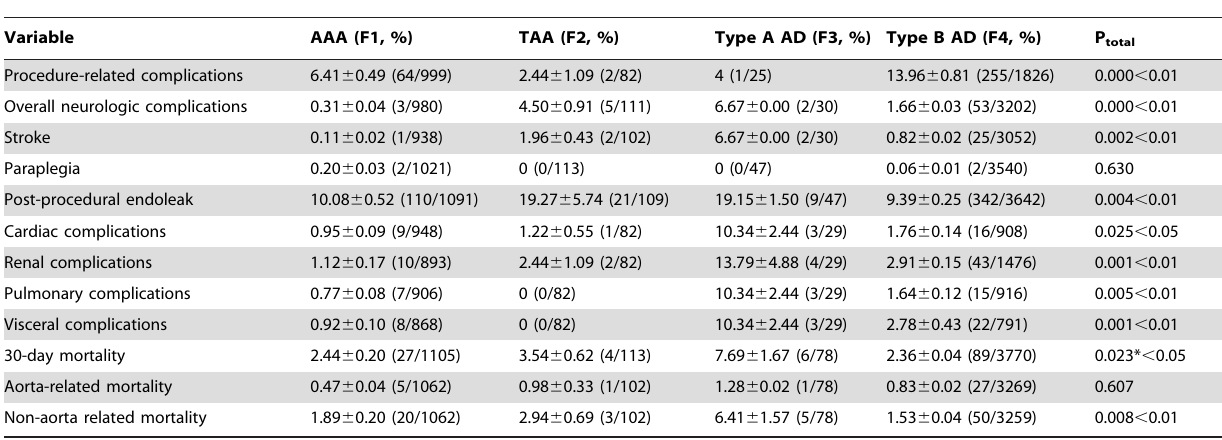
Table 3. 30-day perioperative data of patients with aortic diseases.